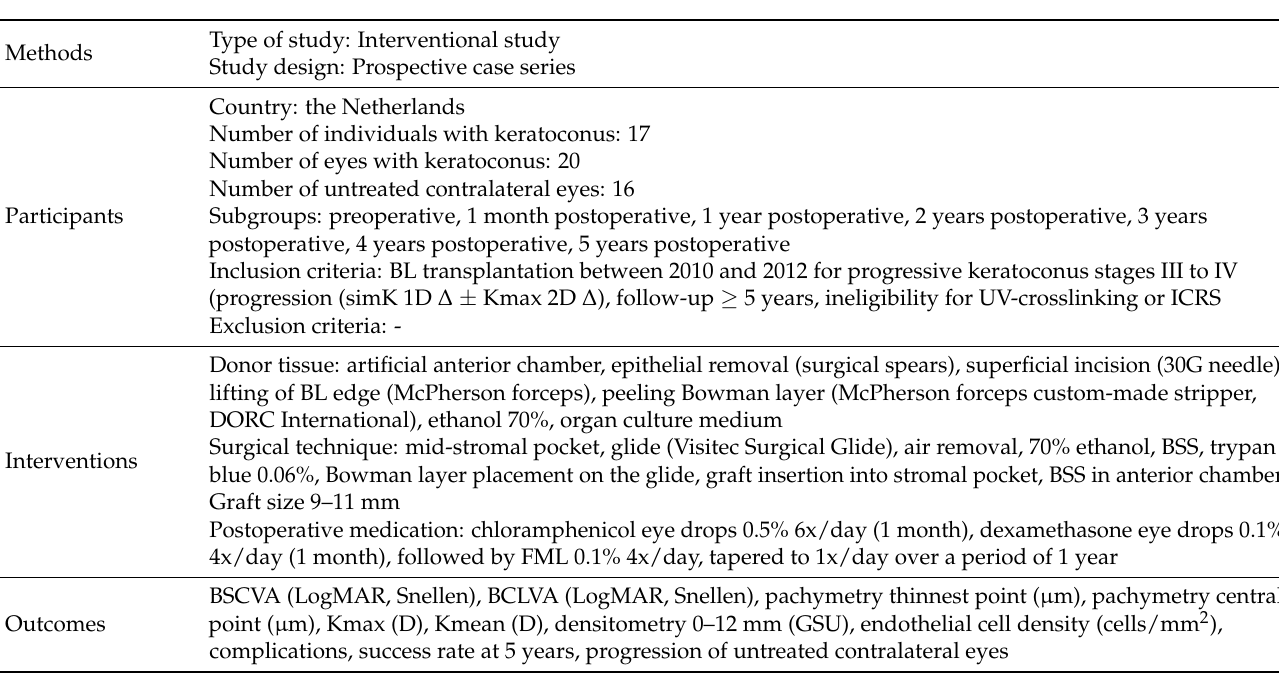
Table A22. Van Dijk 2018 [37].